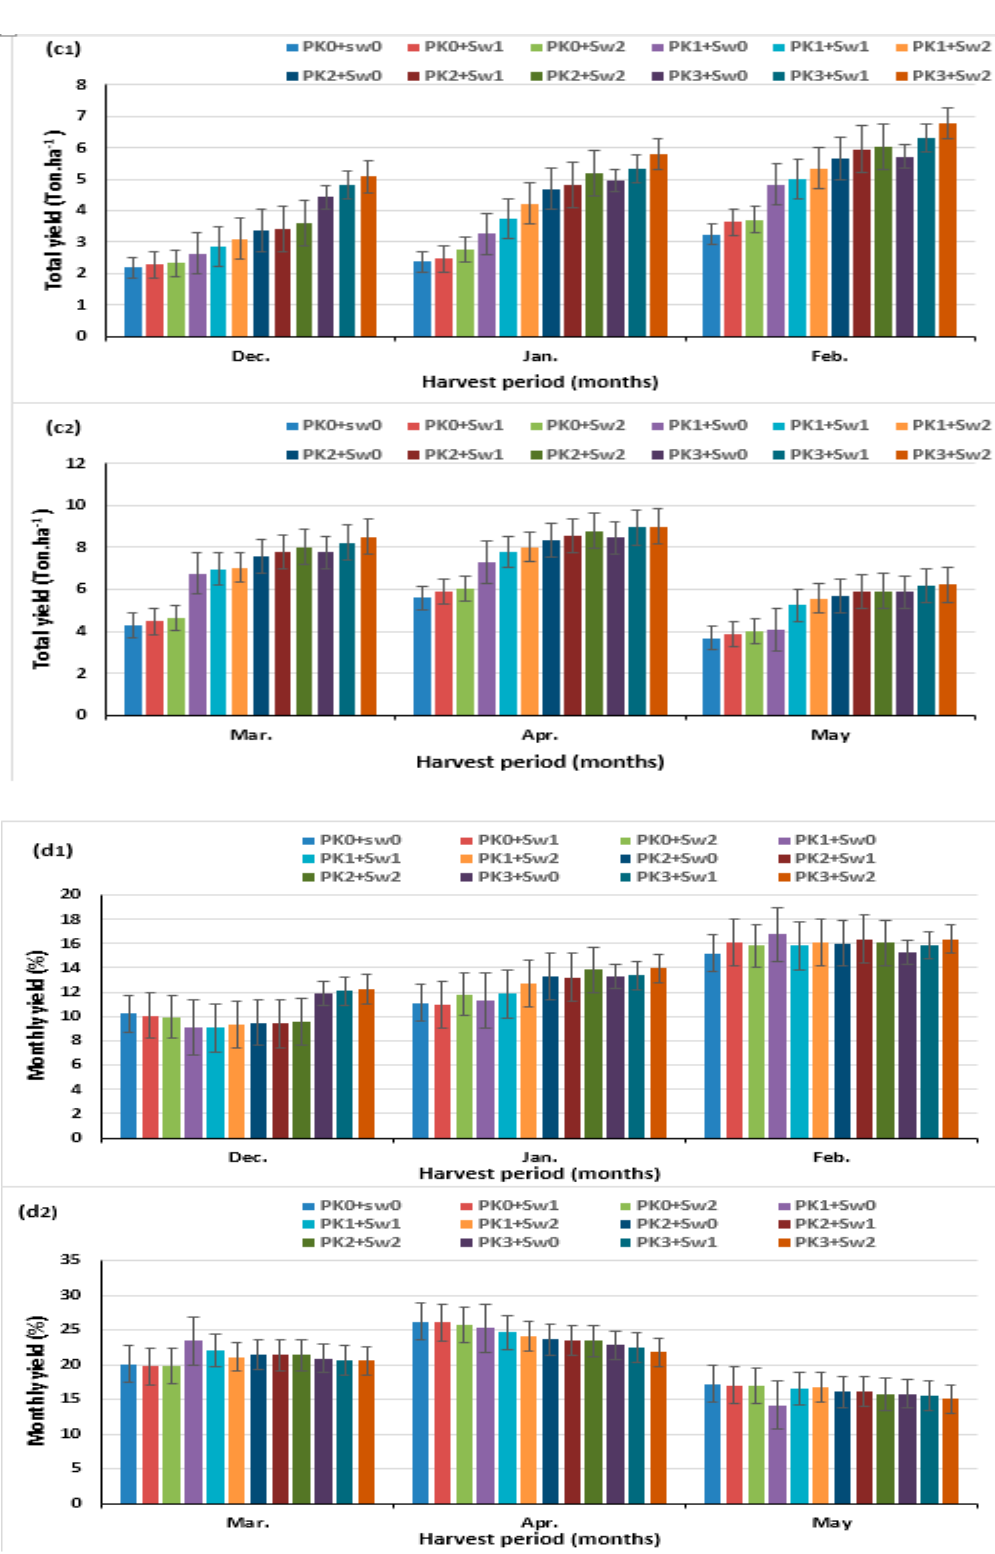
Figure 5. Yield pattern of globe artichoke as affected by the PK fertilizer levels (Control: without, PK 1 : 25, PK 2 : 50 and PK 3 : 75 mL L − 1 ) and seaweed extract rate (Control: without, SW 1 : 5 and SW 2 : 10 mL L − 1 ) on ( a 1 , 2 ) Total yield (Ton ha − 1 ) in season 1; ( b 1 , 2 ) Monthly yield (%) in season 1; ( c 1 , 2 ) Total yield (Ton ha − 1 ) in season 2 and ( d 1 , 2 ) Monthly yield (%) in season 2. Error bars indicate standard deviations of the three replicates.